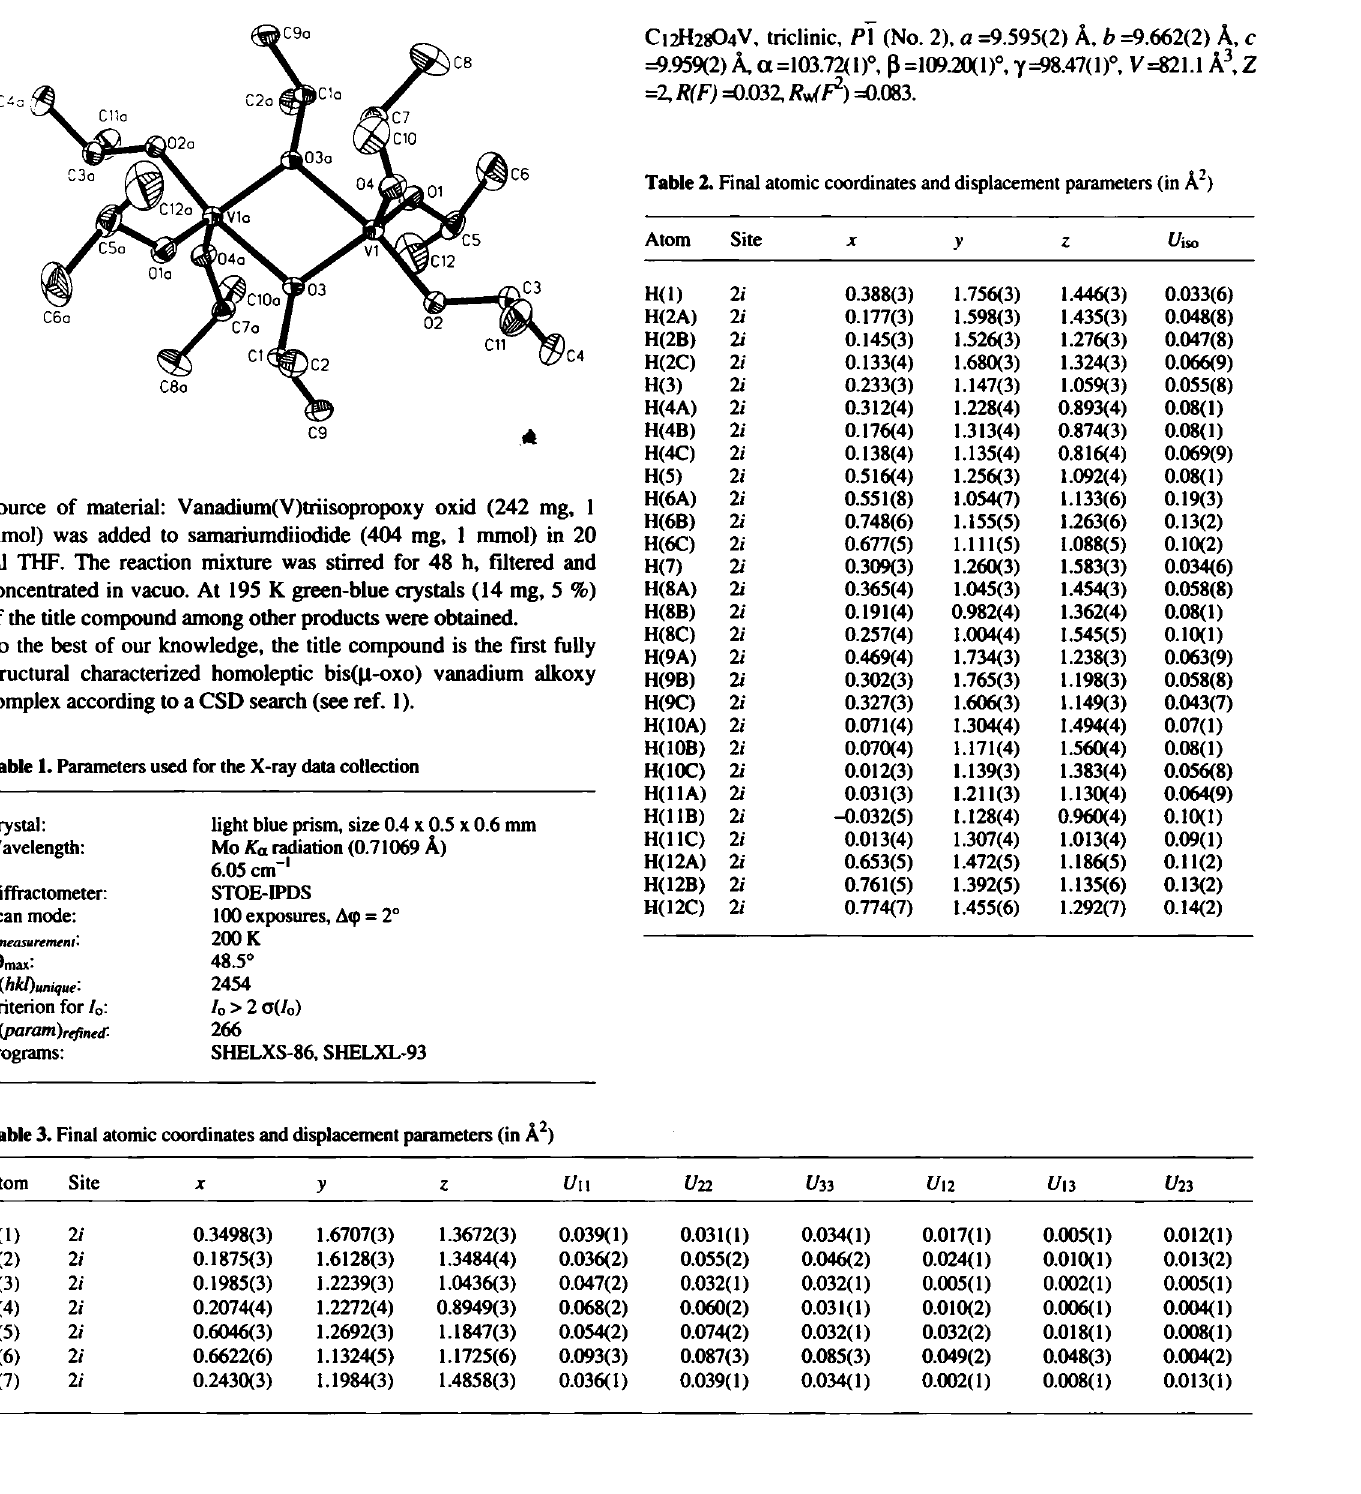
Table 2. Final atomic coordinates and displacement parameters (in Â 2 )